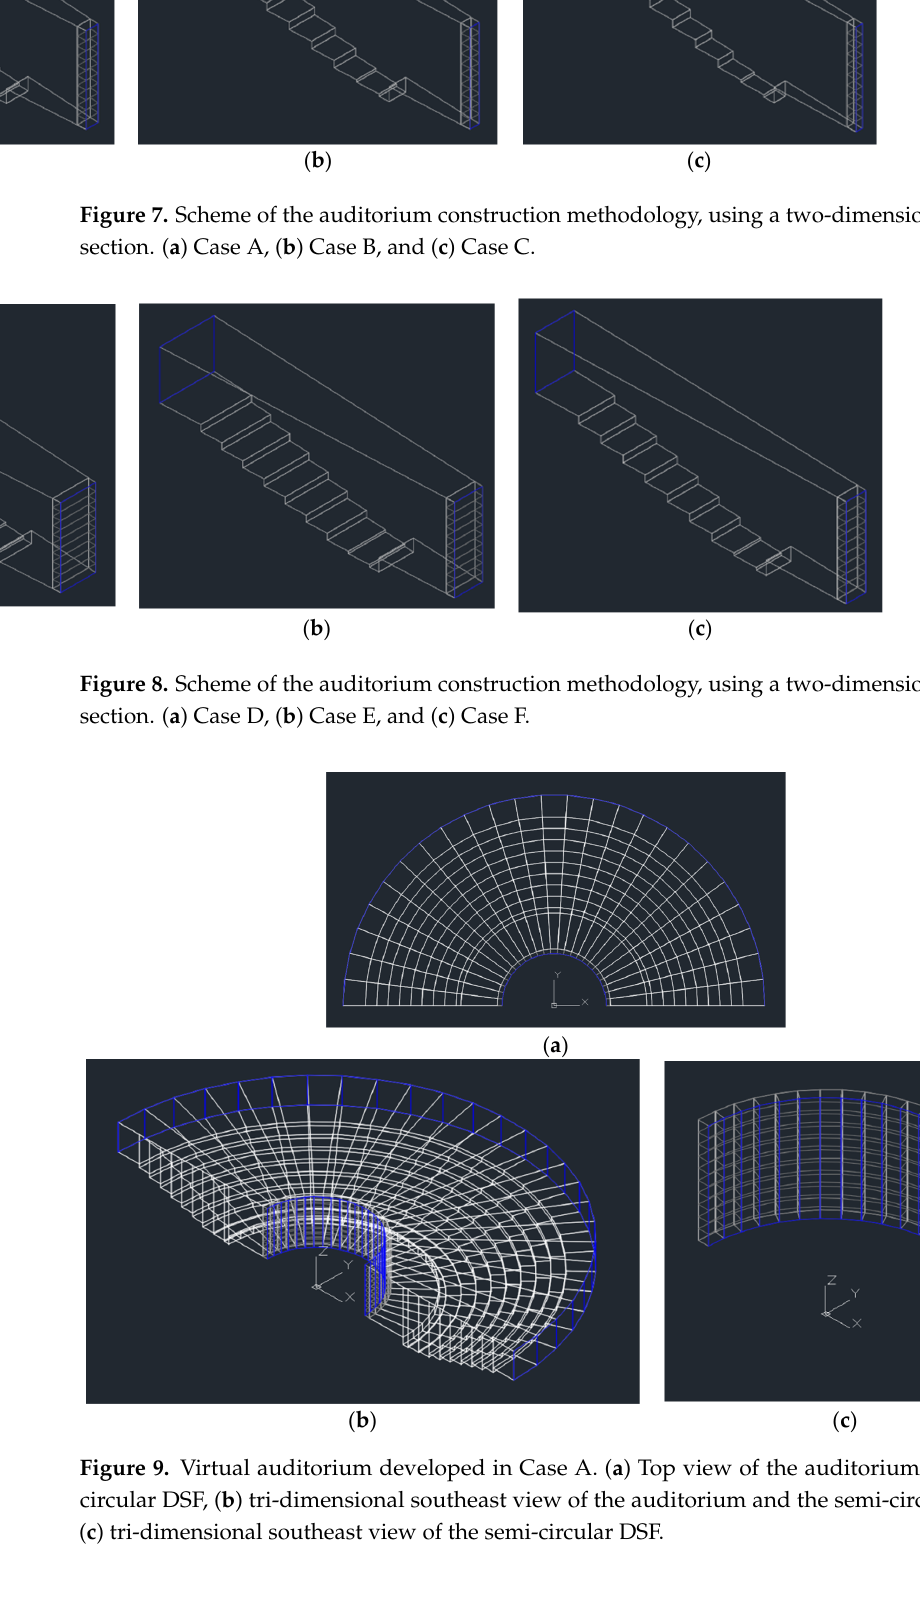
( c ) Figure 10. Virtual auditorium developed in Case B. ( a ) Top view of the auditorium and the semi- circular DSF, ( b ) tri-dimensional southeast view of the auditorium and the semi-circular DSF, and ( c ) tri-dimensional southeast view of the semi-circular DSF.